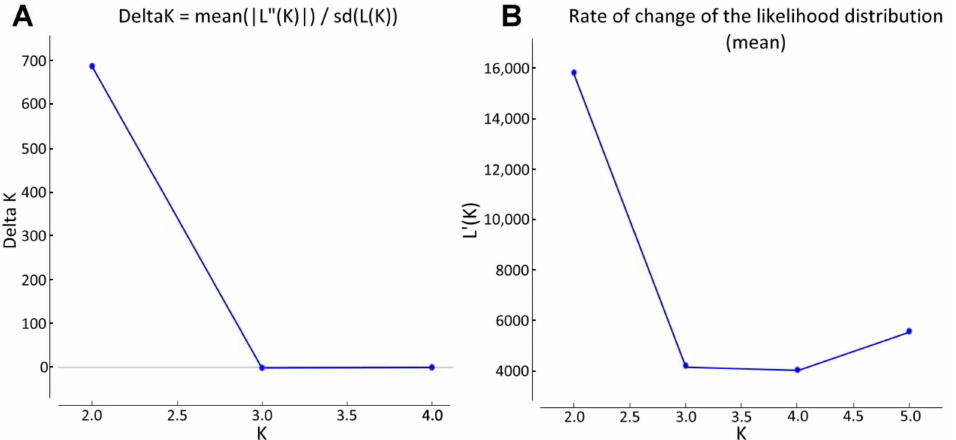
Figure 2. Plot of Delta K values ( A ) and the likelihood distribution ( B ) from the Structure analyses of Ae. biuncialis accessions, obtained through STRUCTURE Harvester web version ( n = 86).